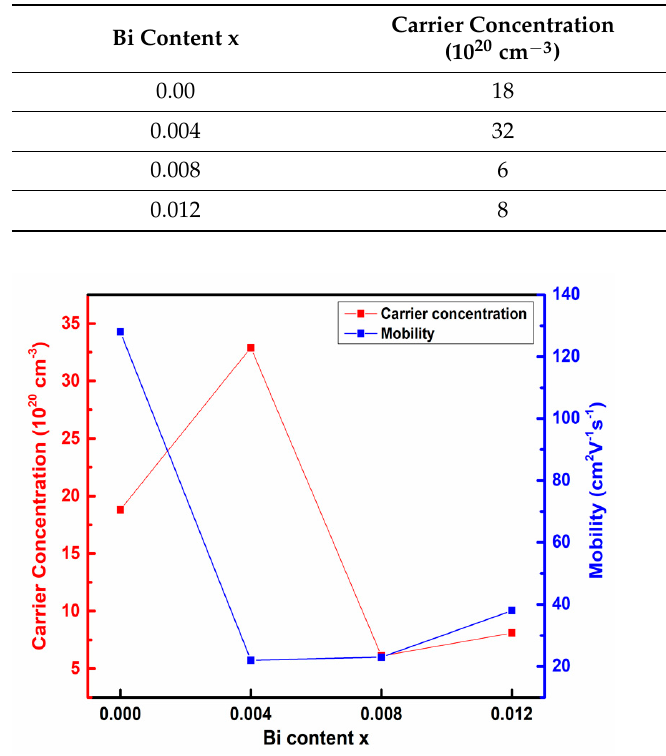
Table 4. Carrier concentration and mobility of Cu 2 − x Bi x Se samples.